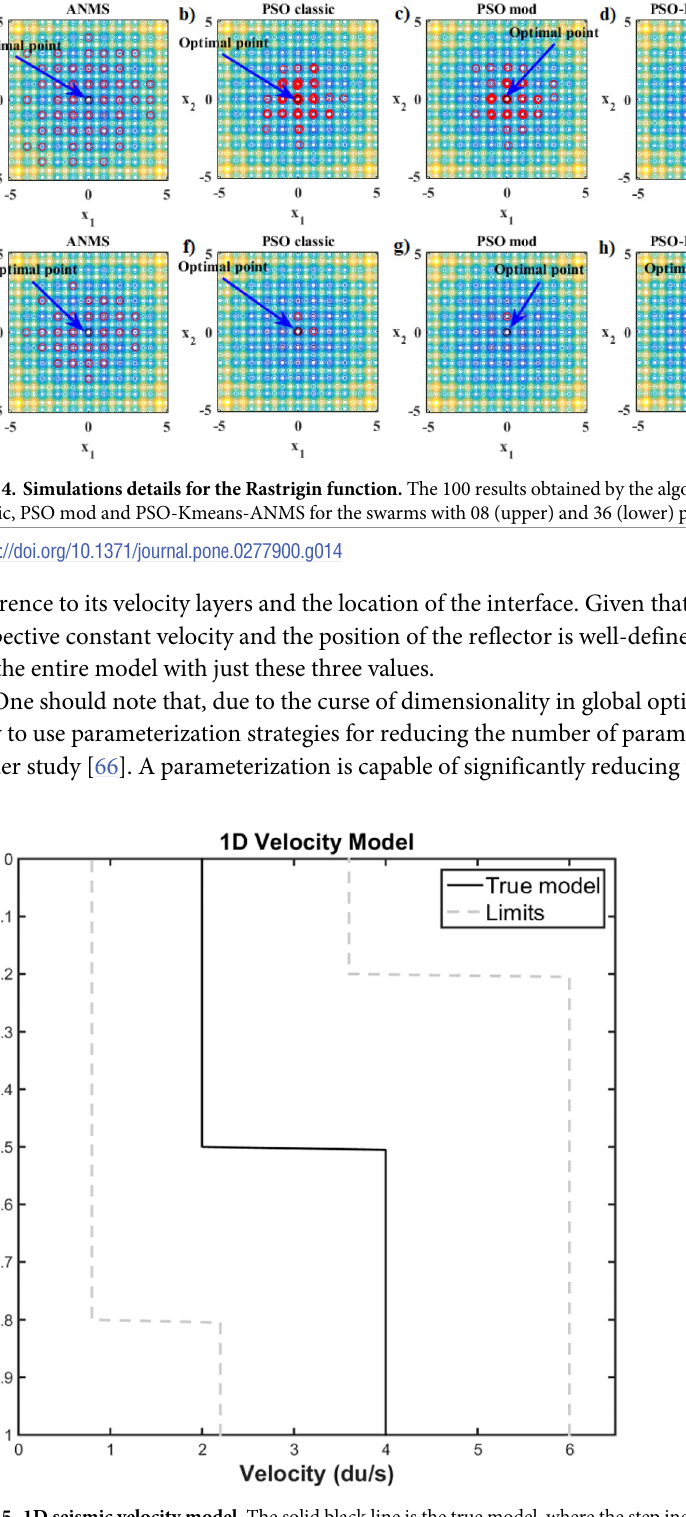
Fig 15. 1D seismic velocity model. The solid black line is the true model, where the step indicates the position of the reflector. The dashed gray lines delimit the overall search space for the model